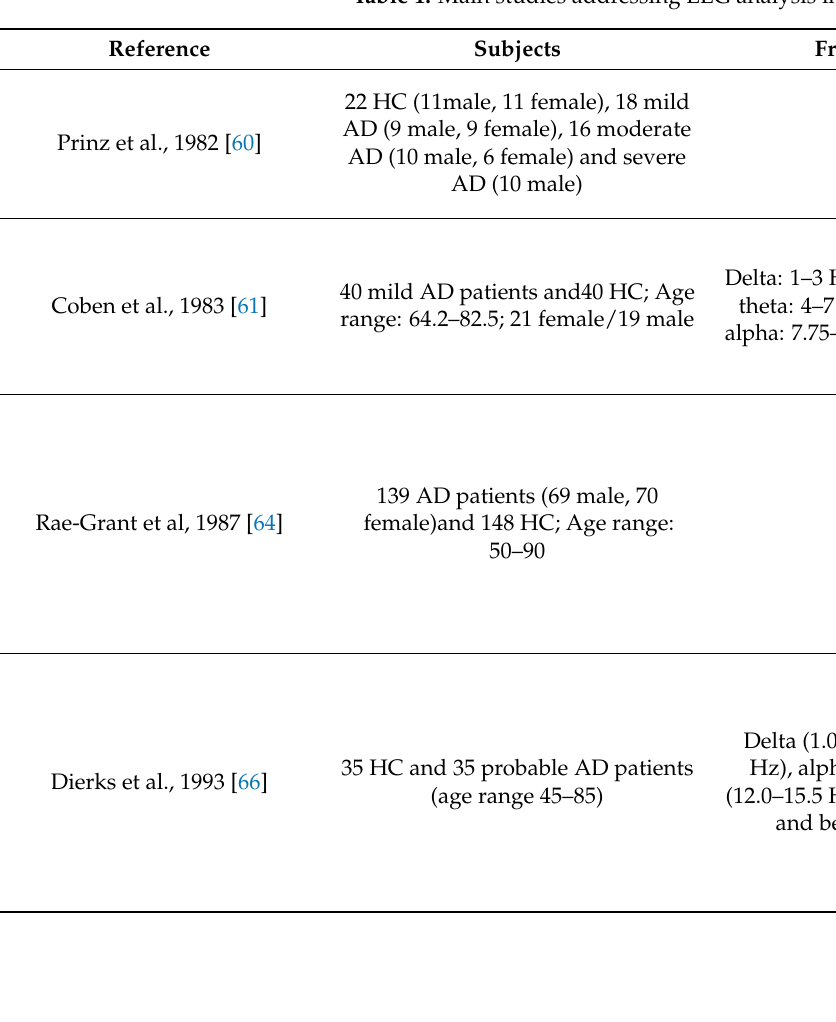
Table 1. Main studies addressing EEG analysis in Alzheimer’s disease with their main findings and listed